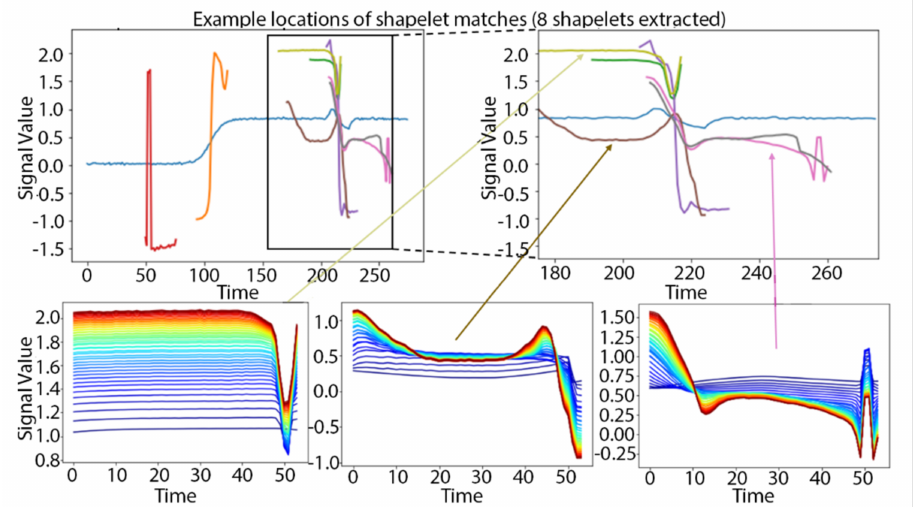
Figure 1. Example of applying Grabocka’s learning TSS method to identify 8 shapelets in the TRACE data. The bottom three subplots demonstrate the step-by-step learning of three selected shapelets, with blue denoting the initial value and red denoting the final trained value of the